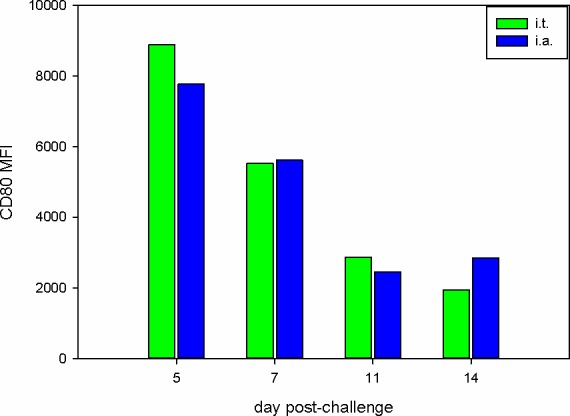
Viral challenge activates BAL macrophages.BAL cells from groups C (i.t.) and D (i.a.) were resuspended in FACS buffer and analysed for HLA-DR and CD80 expression by flow cytometry. Macrophages were defined as HLA-DR+ events and CD80 expression is presented as mean fluorescence intensity (MFI).